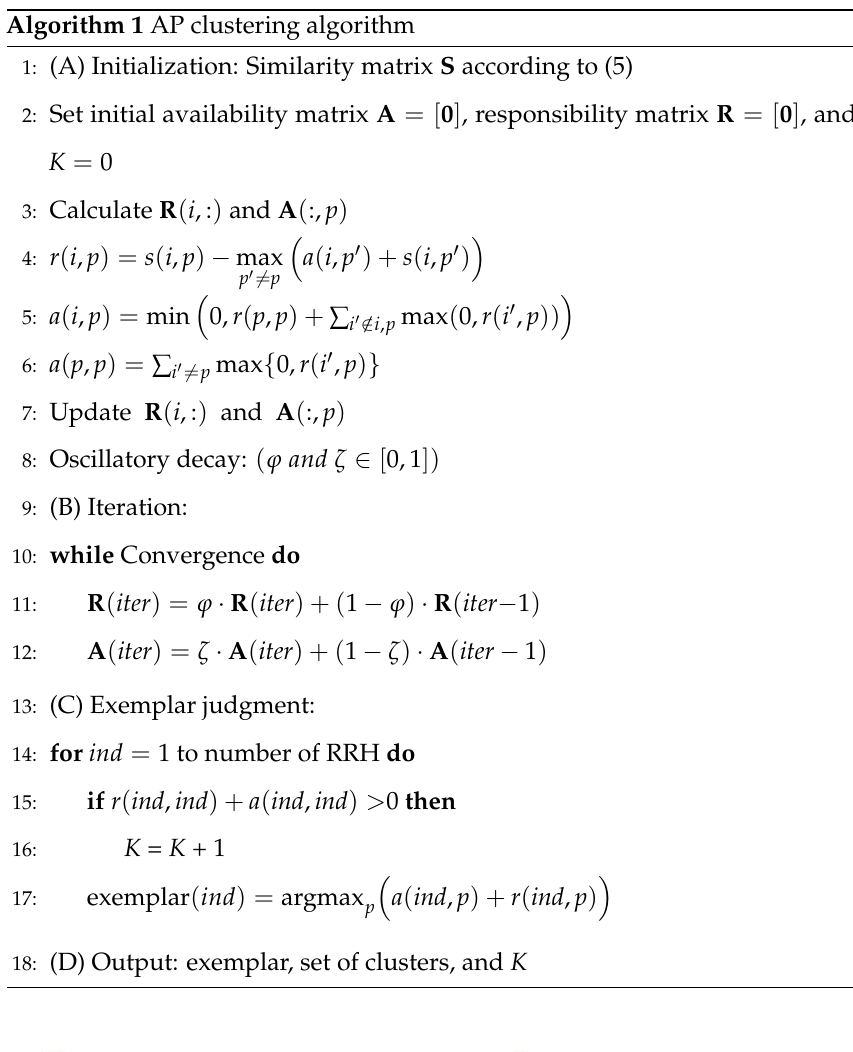
Algorithm 1 AP clustering algorithm